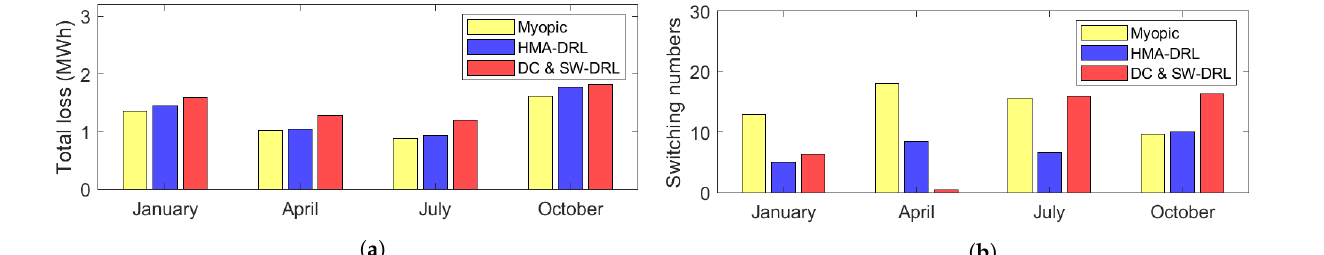
Figure 5. Daily average performance comparison using seasonal data. ( a ) Total loss for test days; ( b ) Switching numbers for test days.